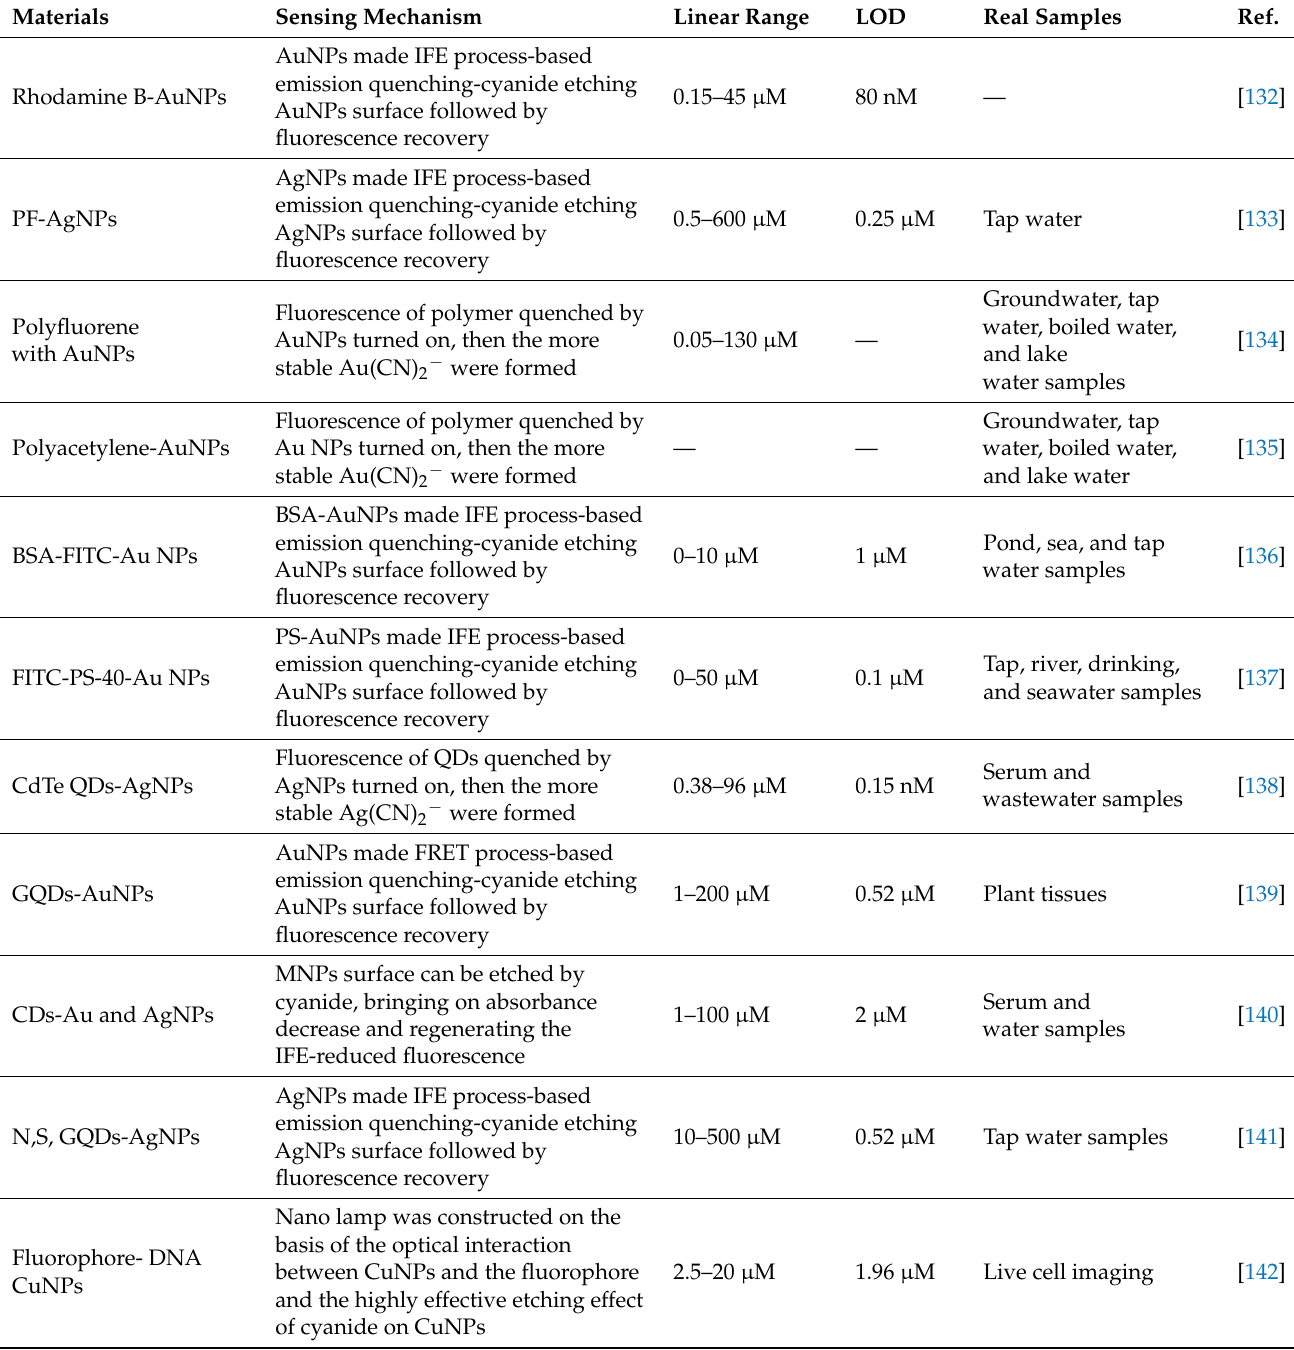
Table 3. Analytical factors of fluorophore-functionalized plasmonic metal